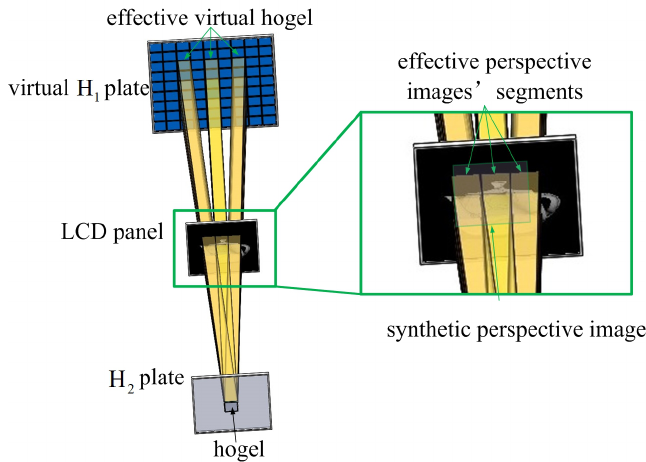
Figure 3. The effective perspective images segments of adjacent hogels are aliased When holographic element is used for the corresponding.